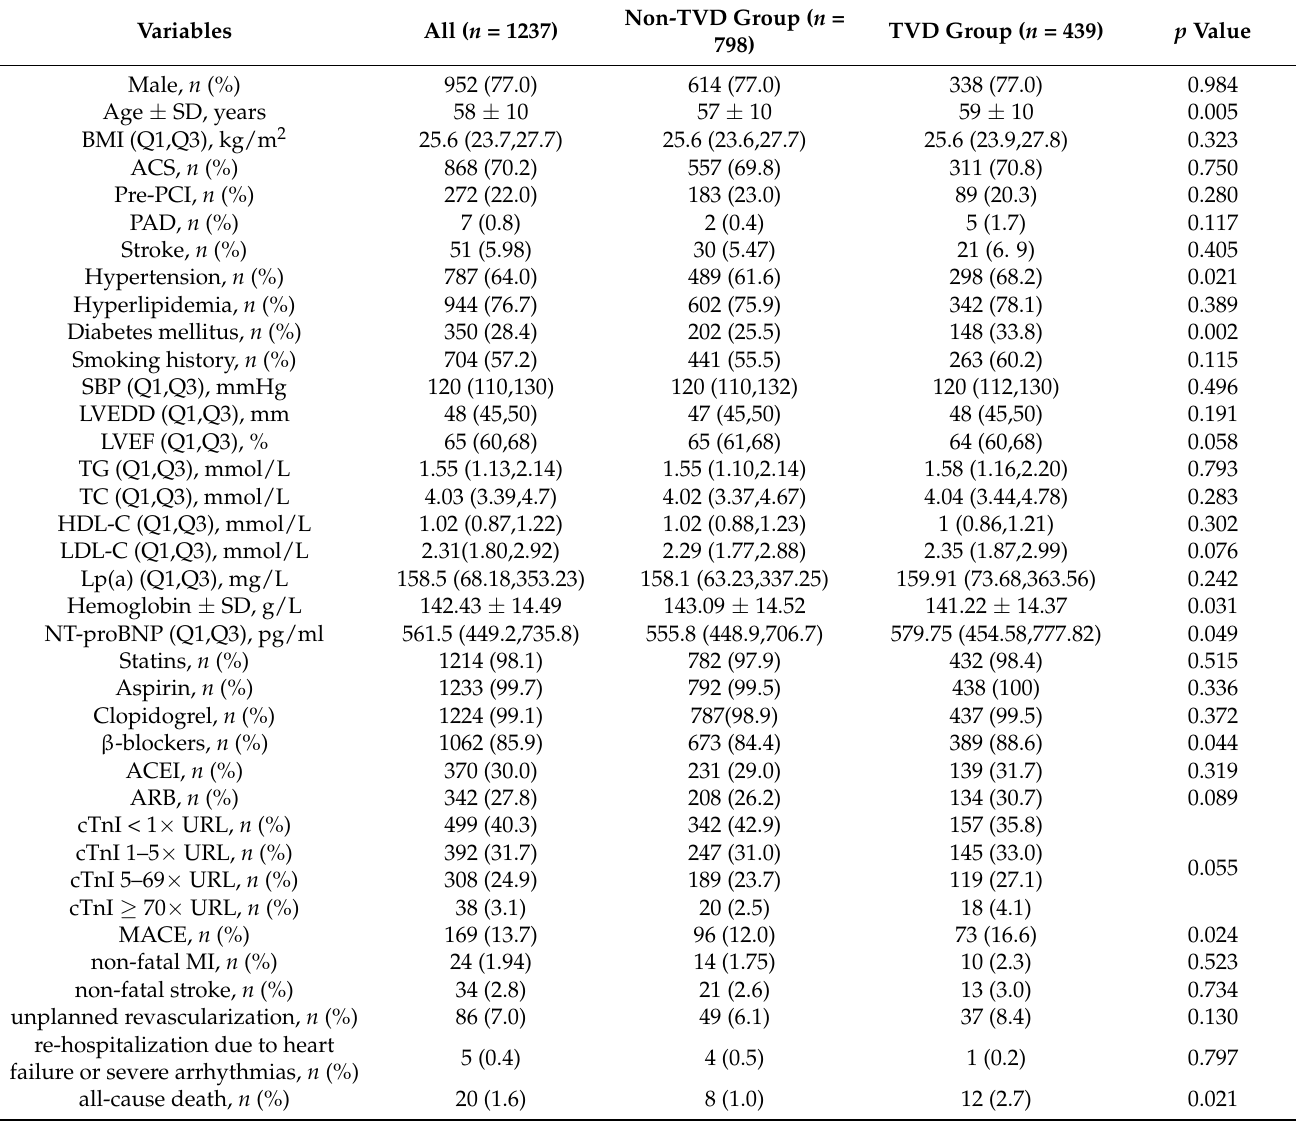
Table 1. Characteristics of the study population by the presence or absence of